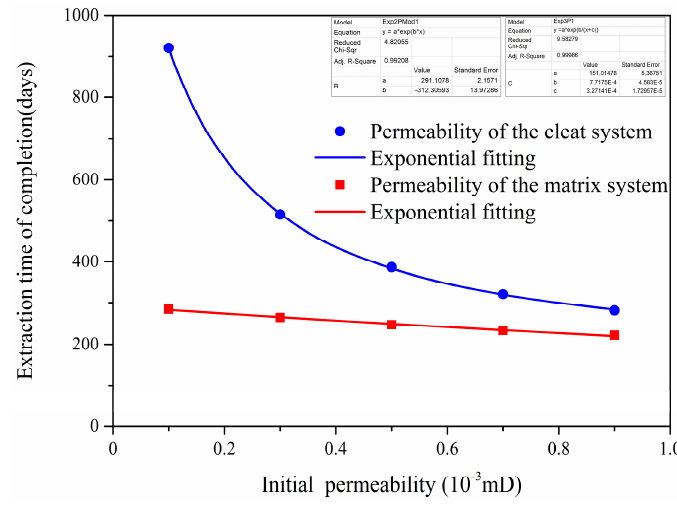
Figure 14. E ff ect of the matrix and fracture permeability on extraction time of completion.